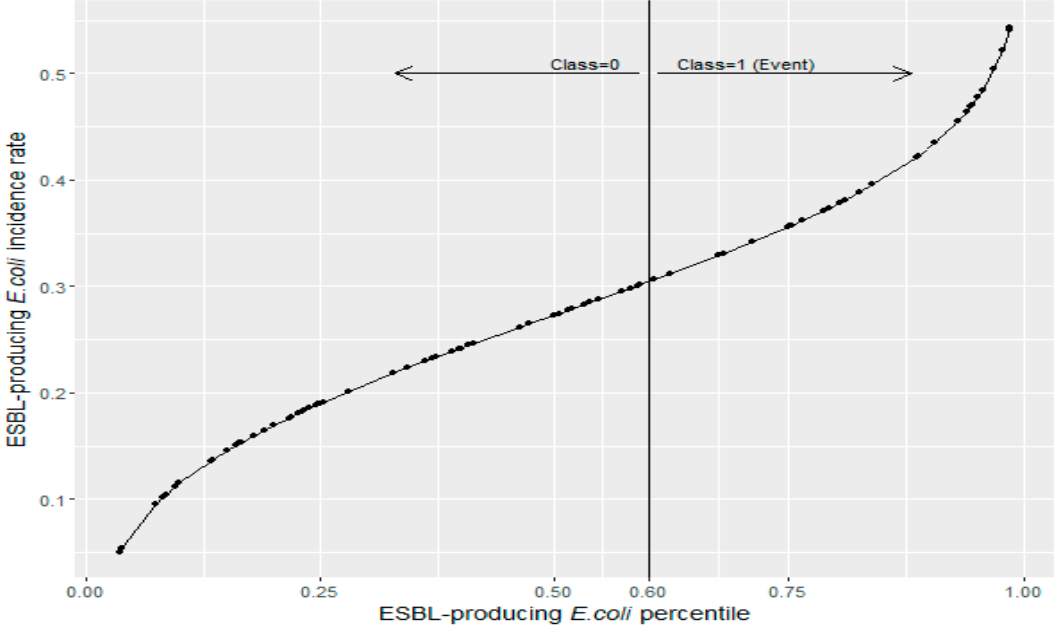
Figure 3. The empirical cumulative distribution function for ESBL-producing E. coli historical data. The solid vertical line represents the 60th percentile (0.288 cases/1000 OBD).